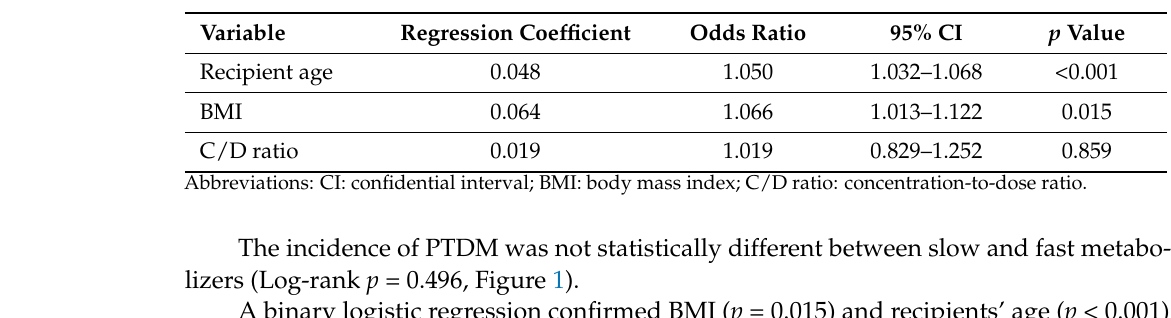
Table 3. Binary logistic regression for PTDM risk factor